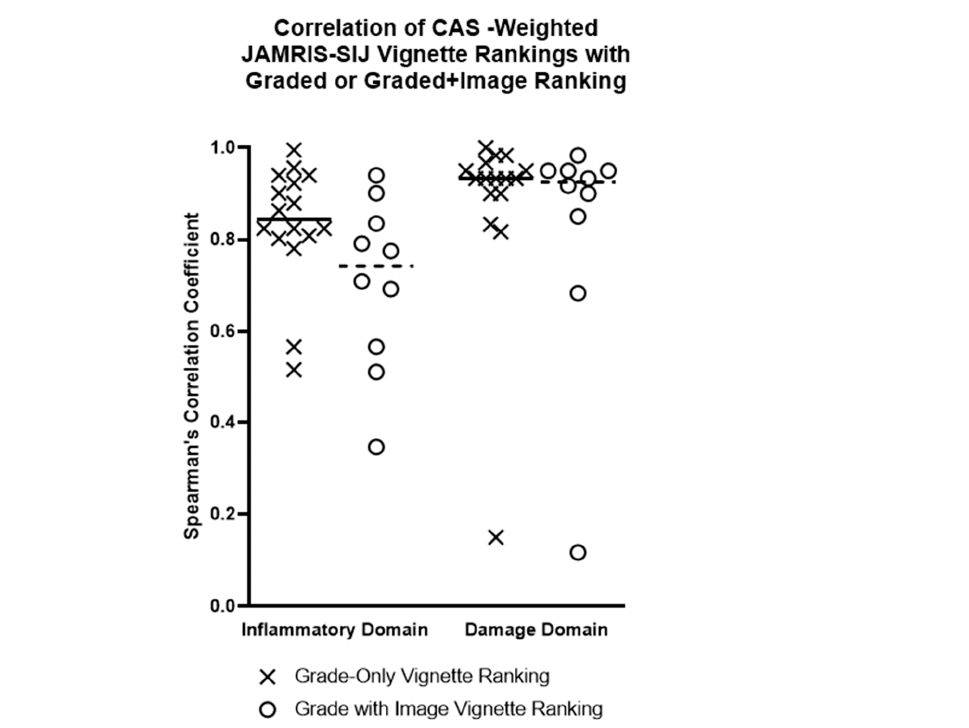
Figure 3. Correlation of CAS-Weighted JAMRIS-SIJ Vignette Ranking with Graded or Image Ranking. Spearman’s rank correlation coefficients are plotted for each expert rater (radiologist and rheumatologist, n = 17) comparing their two methods of producing of vignette ranks, i.e., correlating the experts’ grade-only or graded image-based full profile ranking with the ranking produced by applying the experts’ own CAS-derived weights applied to consensus grades. Horizontal lines represent the median Spearman correlation for each subgroup of participants (X—grade-only vignette ranking, n = 17, O—grade + image vignette ranking, n = 12). The JAMRIS-SIJ MR image + grade vignettes. Table 2. Spearman’s correlation coefficients of four different datasets. Correlation of experts’ prefer- ence for JAMRIS-SIJ measurement item weights for MR image, JAMRIS-SIJ score vignettes and a com- bination of MR image and score vignettes. CAS—conjoint analysis survey IQR—interquartile range. Spearman Correlation Coefficient of CAS-Weighted JAMRIS-SIJ vs. Graded ± Image Vignette